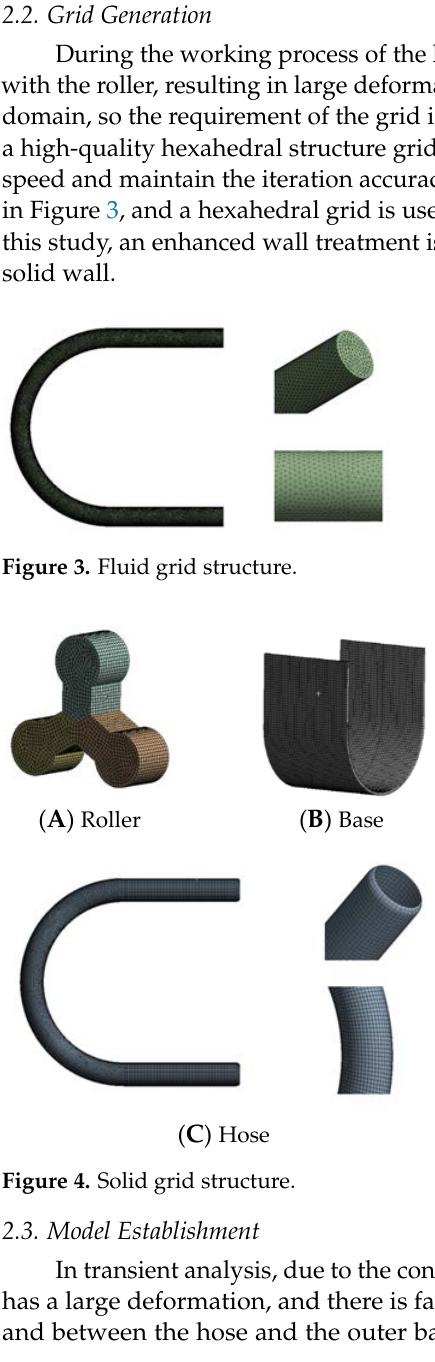
Figure 2. Assembly process diagram.